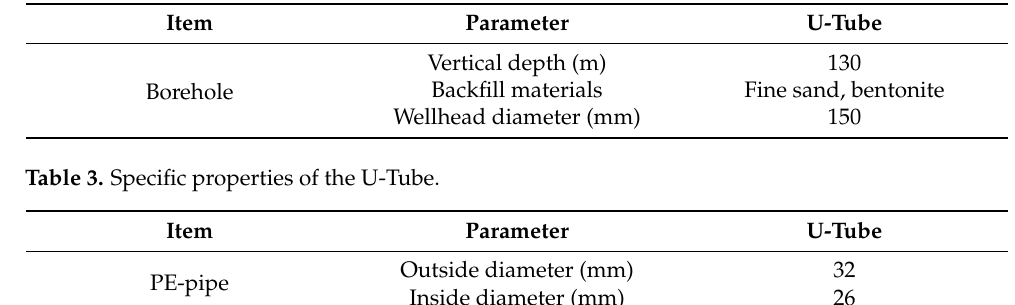
Table 2. Specific properties of the borehole.